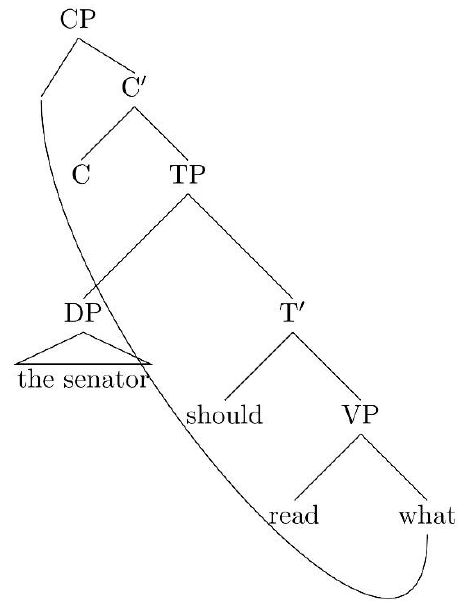
Figure 21. Multidominance structure for wh-movement